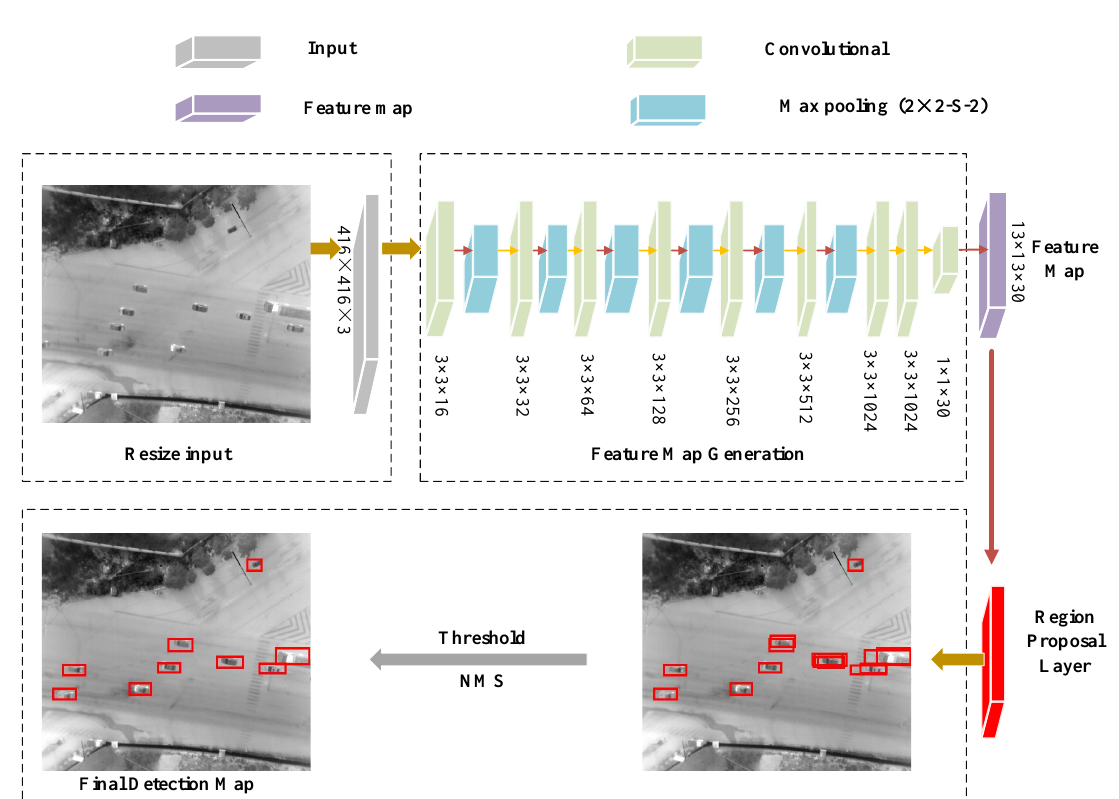
Figure 4. The architecture: The detection network is composed of nine convolutional layers, six pooling layers and a region proposal layer. Input image : 416 × 416 × 3. Output feature map: 13 × 13 × 30. The convolutional layers: 3 × 3 filters; The pooling layers: max pooling (2 × 2 with 2 stride). After each pool, filter channels double. We add a region proposal layer following the feature map, which is designed to generate bounding boxes, and then carry out threshold and NMS (Non Maximum Suppression)